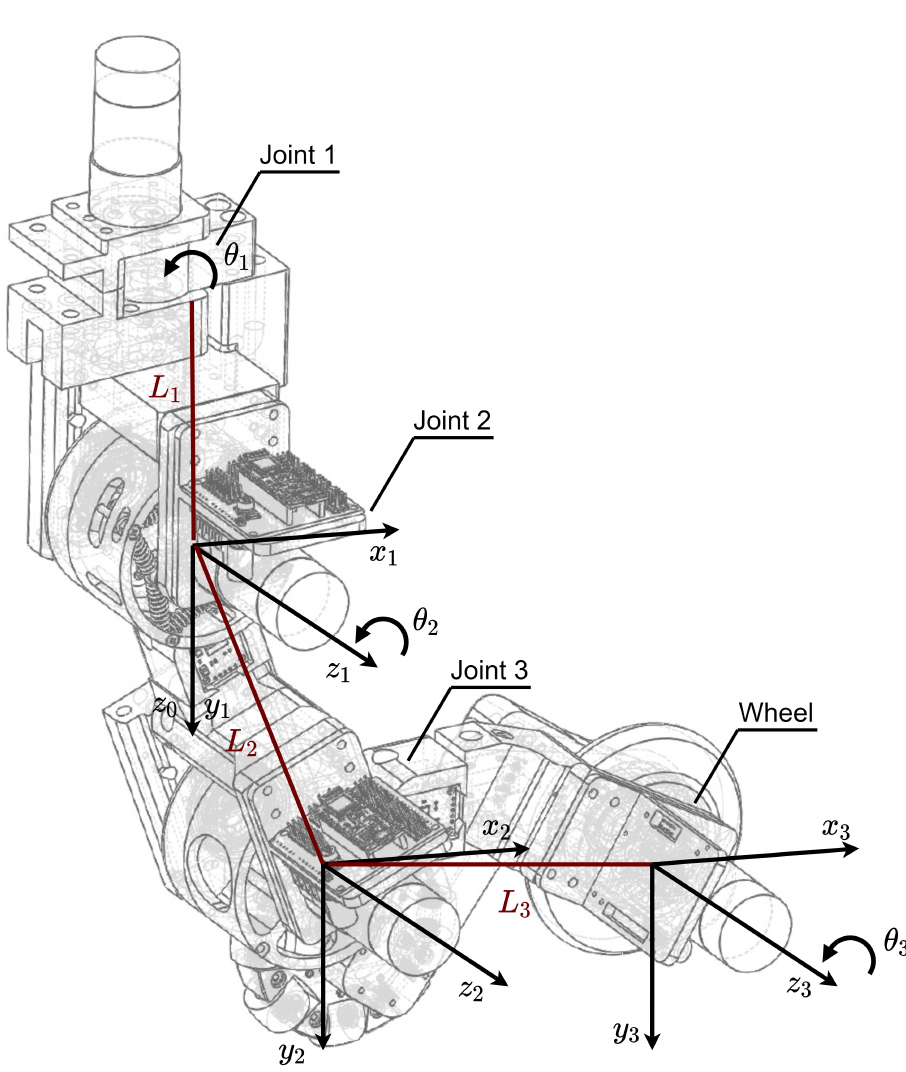
Figure 2. Leg with axis, links, and joints numbering.